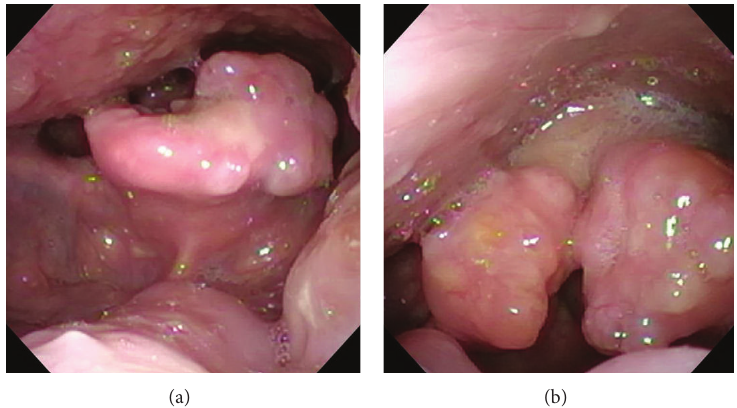
Figure 1: Color photographs taken during flexible indirect laryngoscopy. The vallecula is uninvolved, and an irregular mass is seen on the laryngeal surface of the epiglottis (a). Irregular, submucosal growths are seen on bilateral arytenoids, with pooling of secretions in the postcricoid region (b).